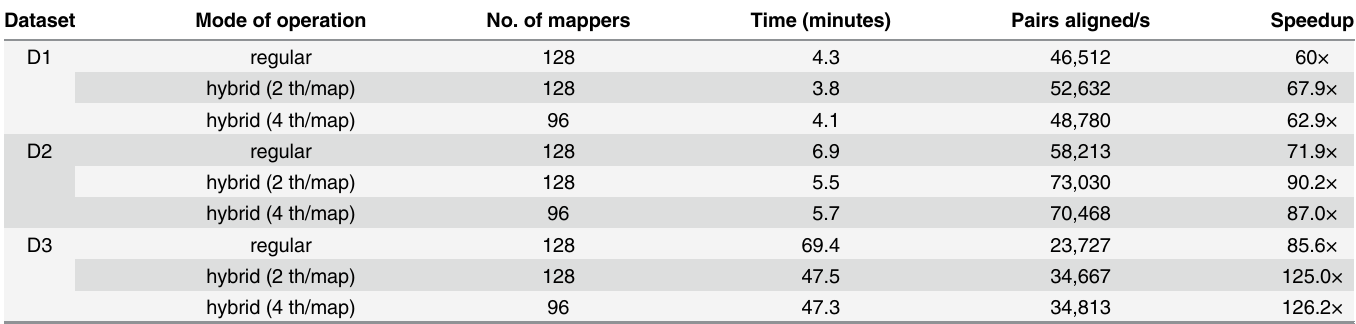
Table 4. Summary of the performance results of